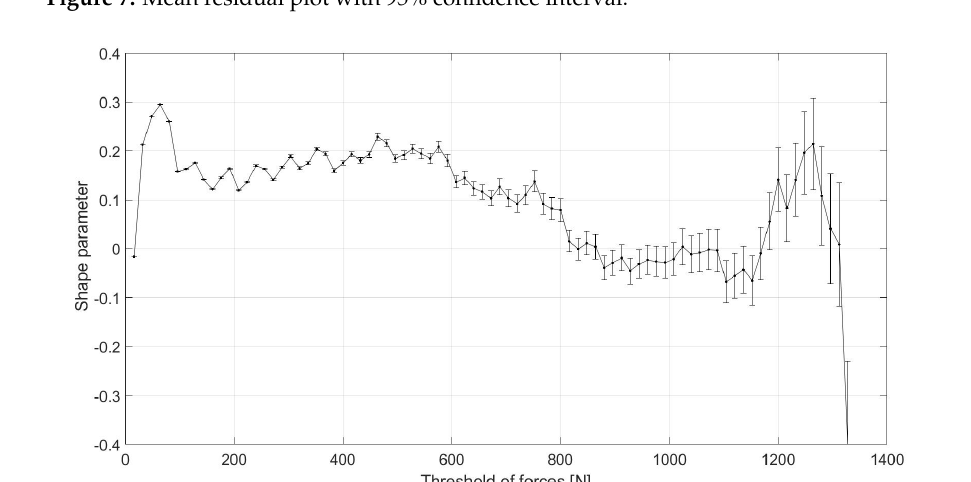
Figure 7. Mean residual plot with 95% confidence interval.